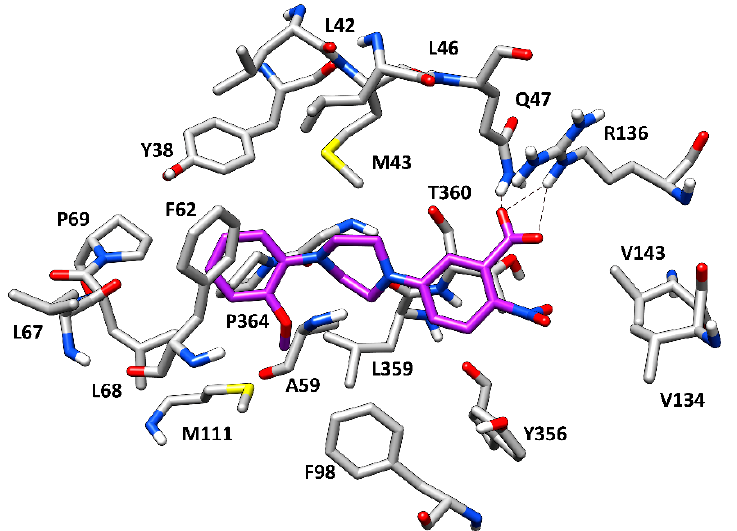
Figure 3. Minimized average structure of the compound CPD5 (purple) in complex with h DHODH. The protein residues surrounding the ligands, constituting the binding site, are shown as grey sticks, while the hydrogen bonds are shown as black dashed lines.